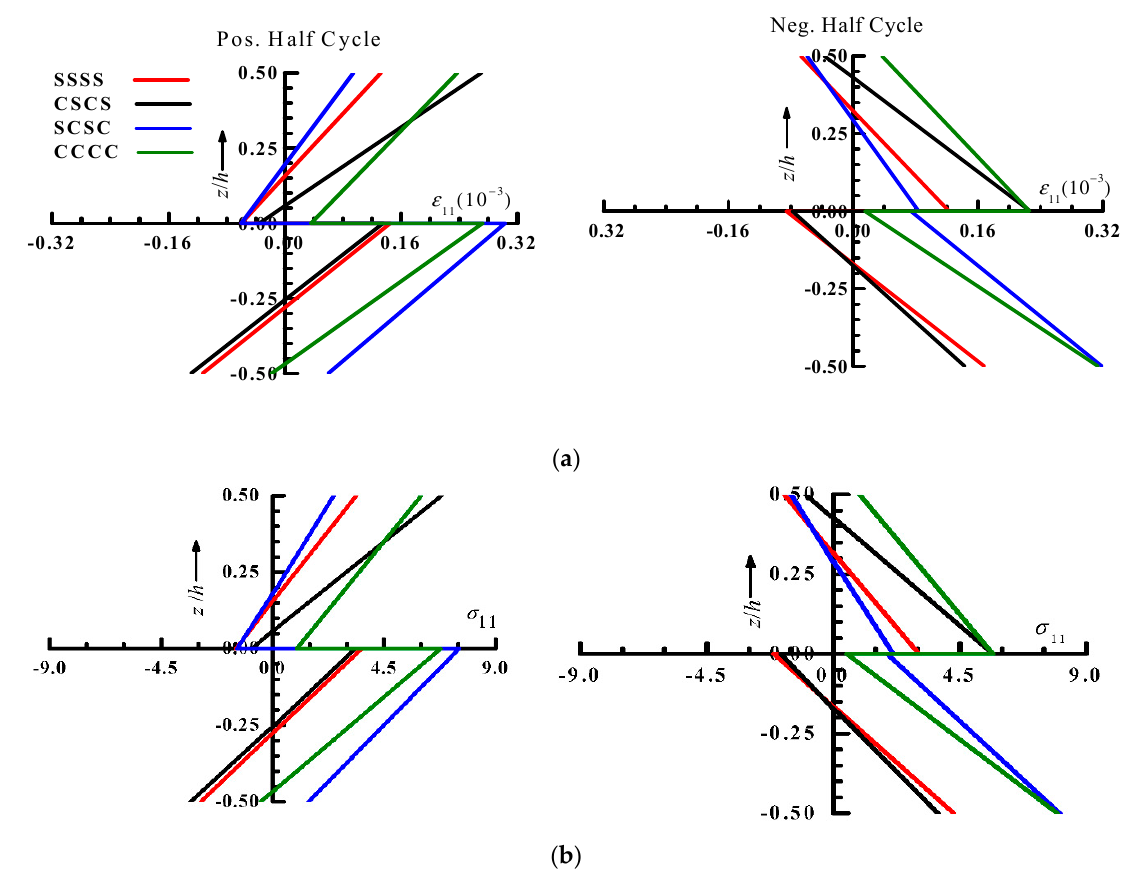
Figure 3. ( a ) Nonlinear fiber-direction normal strain ( ε 11 ) and ( b ) stress ( σ 11 ) distribution corresponding to the peak amplitude in Figure 2b.